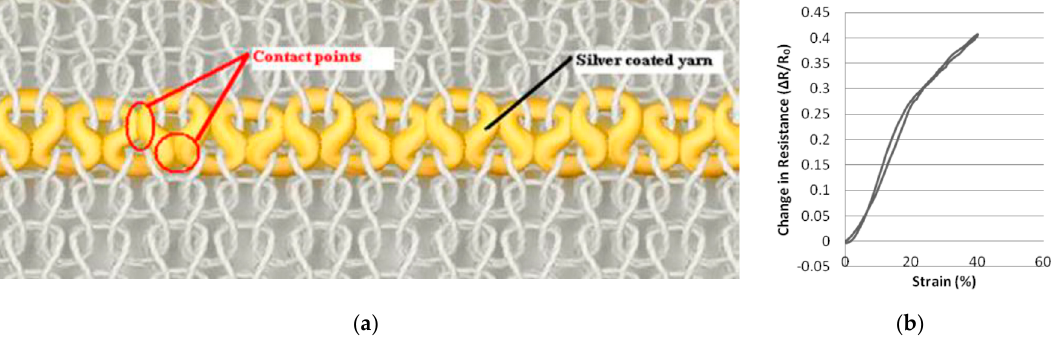
Figure 10. ( a ) Loop-wise embedded conductive yarn in knitted interlock structure; ( b ) electromechanical response